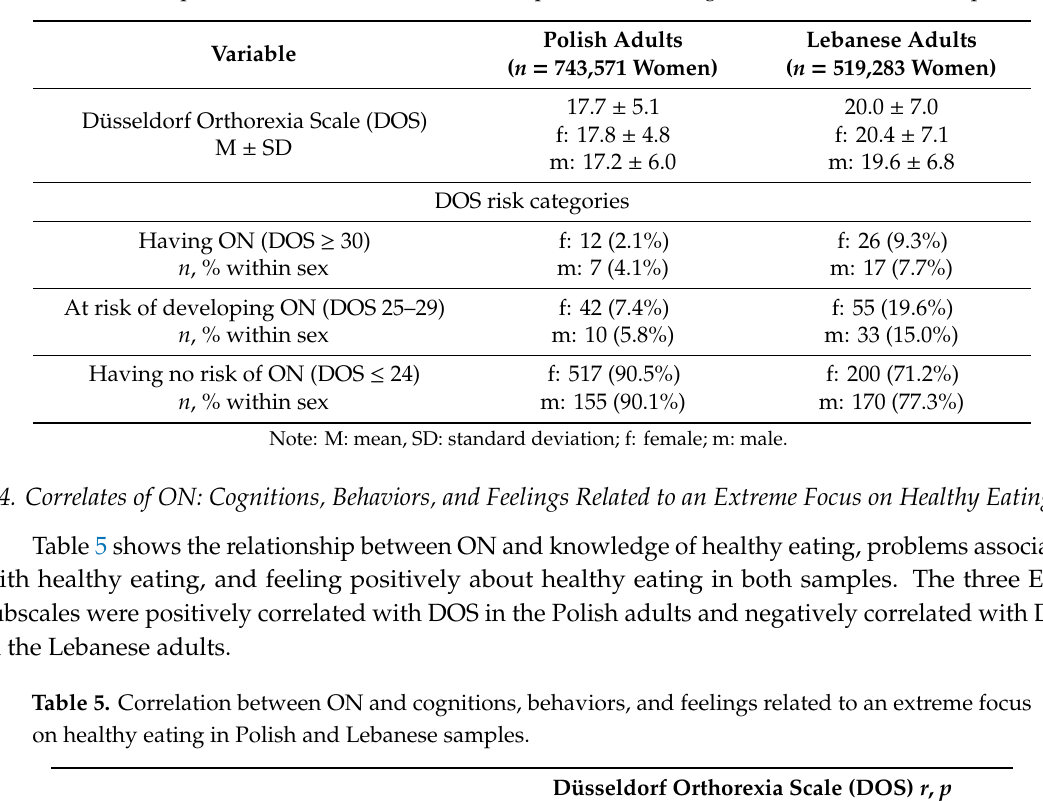
Table 5. Correlation between ON and cognitions, behaviors, and feelings related to an extreme focus on healthy eating in Polish and Lebanese samples. Düsseldorf Orthorexia Scale (DOS) r , p Polish Adults Lebanese Adults Knowledge of healthy eating 0.396, p < 0.001 − 0.635, p < 0.001 Z , p − 20.38; p < 0.001 Problems associated with healthy eating 0.493, p < 0.001 − 0.633, p < 0.001 Z , p − 22.43; p < 0.001 Feeling positively about healthy eating 0.325, p < 0.001 − 0.628, p < 0.001 Z , p − 18.75; p <